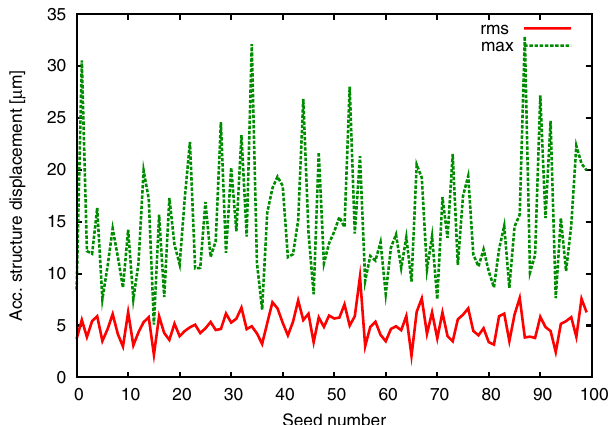
FIG. 20. Average emittance growth for 50 seeds and a beam modeled by 969 macroparticles. The performance of knobs constructed from these seeds themselves is very similar to that of knobs constructed using 50 other seeds and a 147- macroparticle model. The small difference is exclusively caused by the use of a different group of seeds.